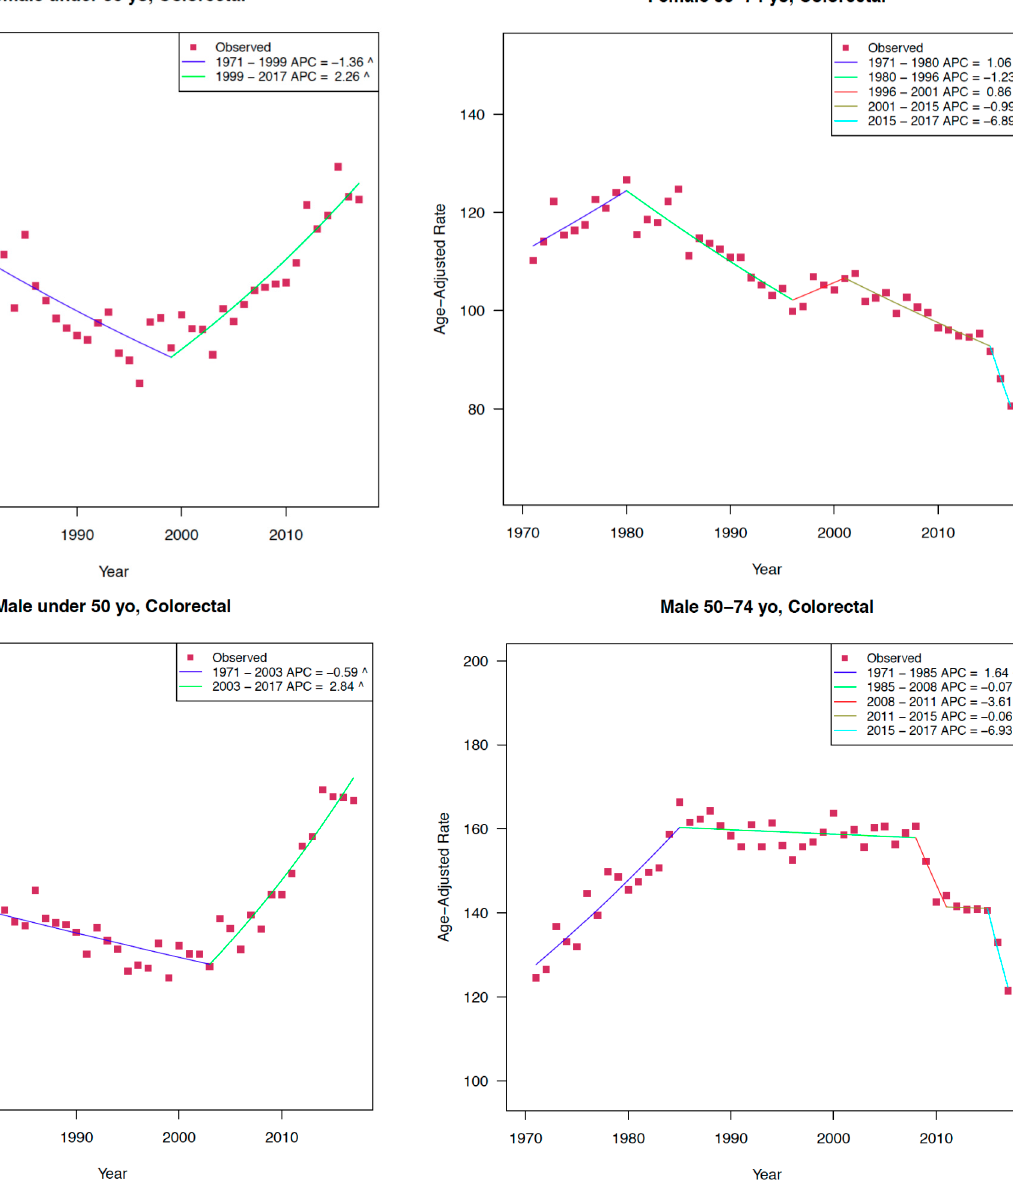
Figure 2. Colorectal cancer incidence trends by age group, Canada 1970–2017. Reprinted with the permission from Ref. [2]